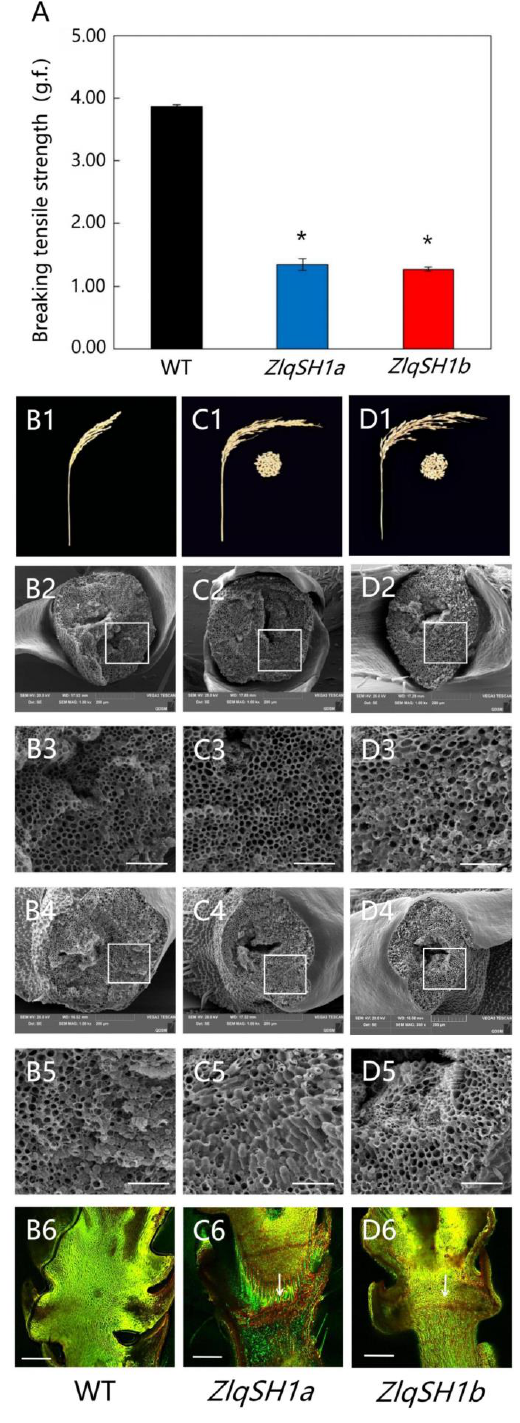
Figure 5. Comparison of the breaking tensile strength (BTS) and results of scanning electron mi- croscopy (SEM) of fracture surfaces and laser confocal microscopy of the longitudinal section of the AL in wild type (WT) and ZlqSH1a and ZlqSH1b over-expressing plants. ( A ) Comparison of the